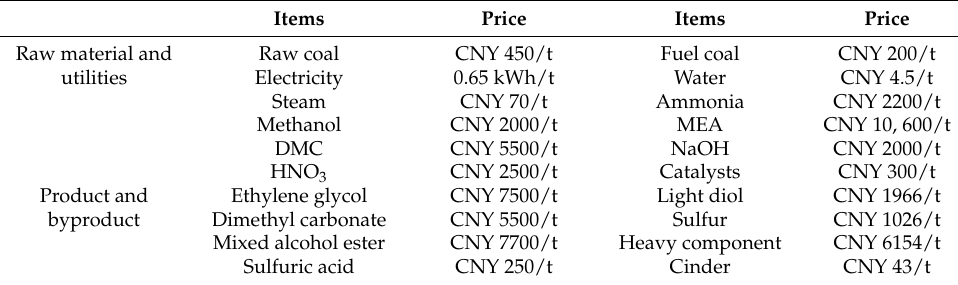
Table 6. Average market price of main raw material, utilities, product and